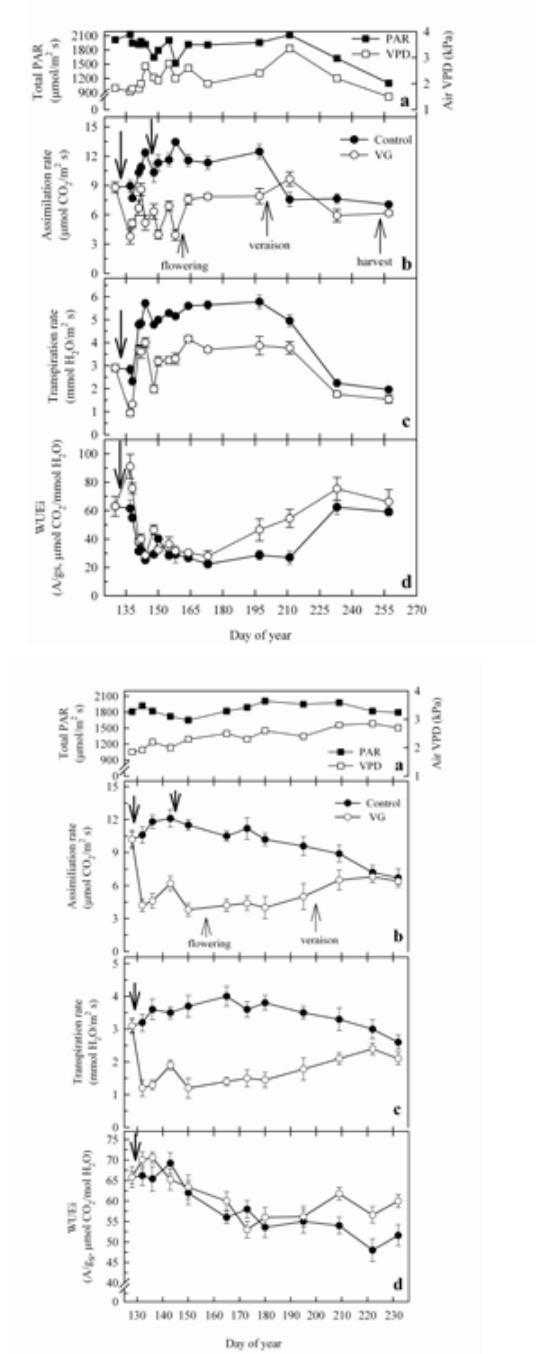
Fig. 3 - Seasonal trends of air vapour pressure deficit (VPD) and total photo - synthetic active radiation (PAR) (a), assimilation rate (b), transpira - tion rate (c) and intrinsic water use efficiency (d) recorded on fully expanded, median Sangiovese (top image) and Ciliegiolo (bottom image) leaves sprayed twice with anti-transpirant Vapor Gard ® at 3% (T) or left unsprayed (C). Bold arrows indicate the time of ap - plication. Data are means ± se (from Palliotti et al.,